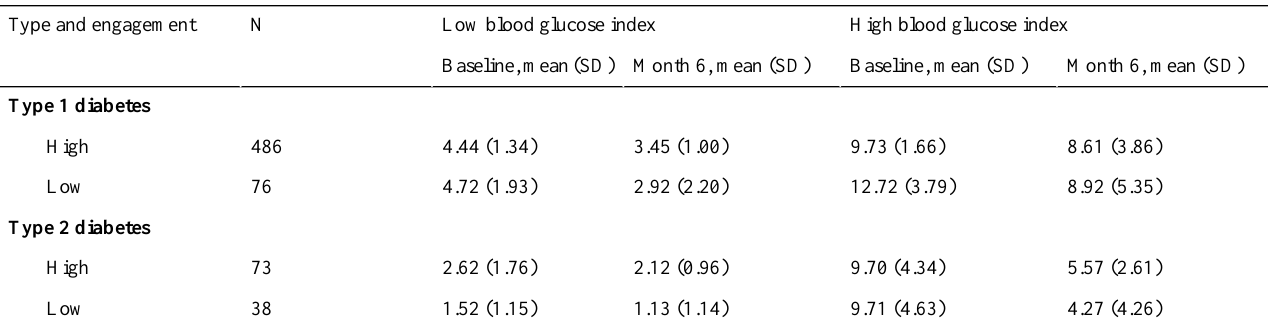
Table 3. The evolution of both low blood glucose index and high blood glucose index for type 1 diabetes and type 2 diabetes users.